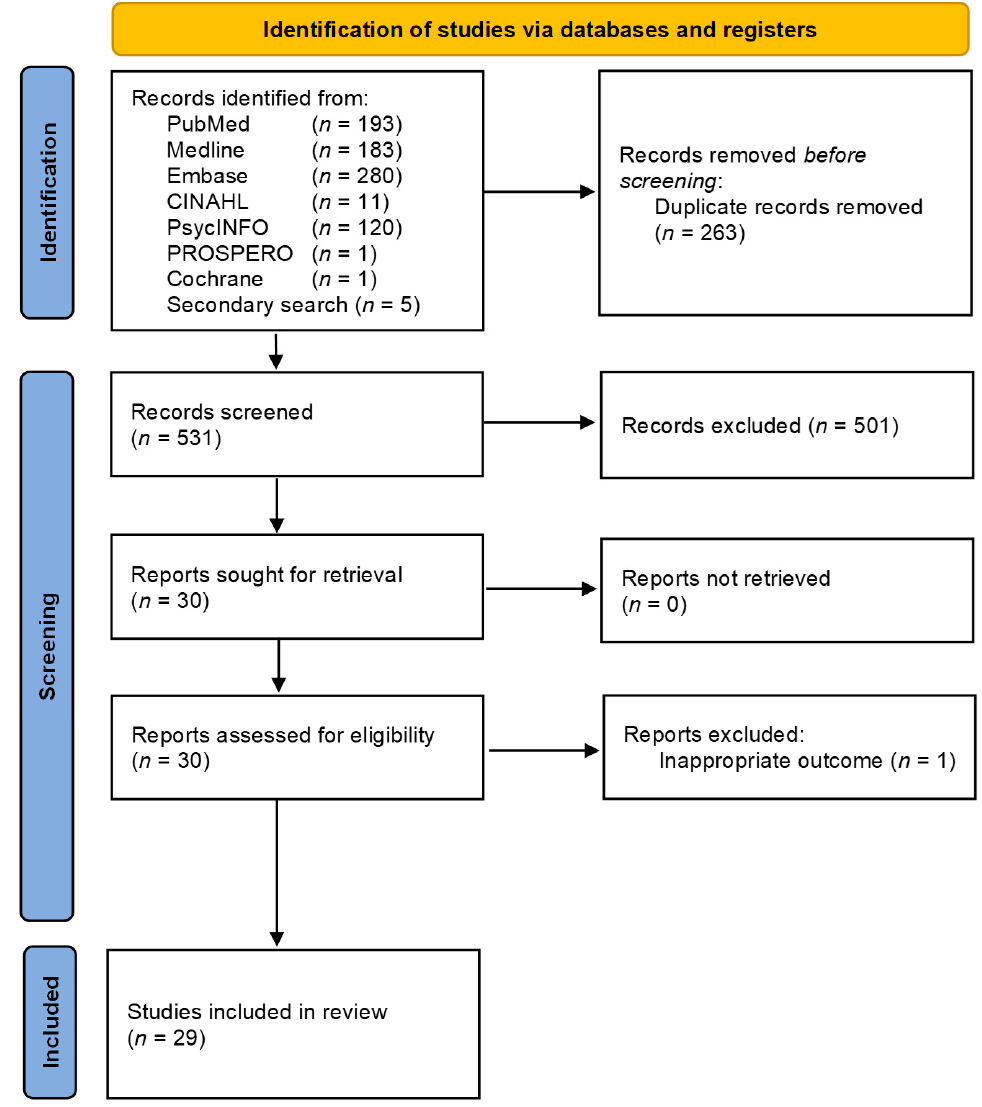
Figure 1. PRISMA flow diagram of study selection